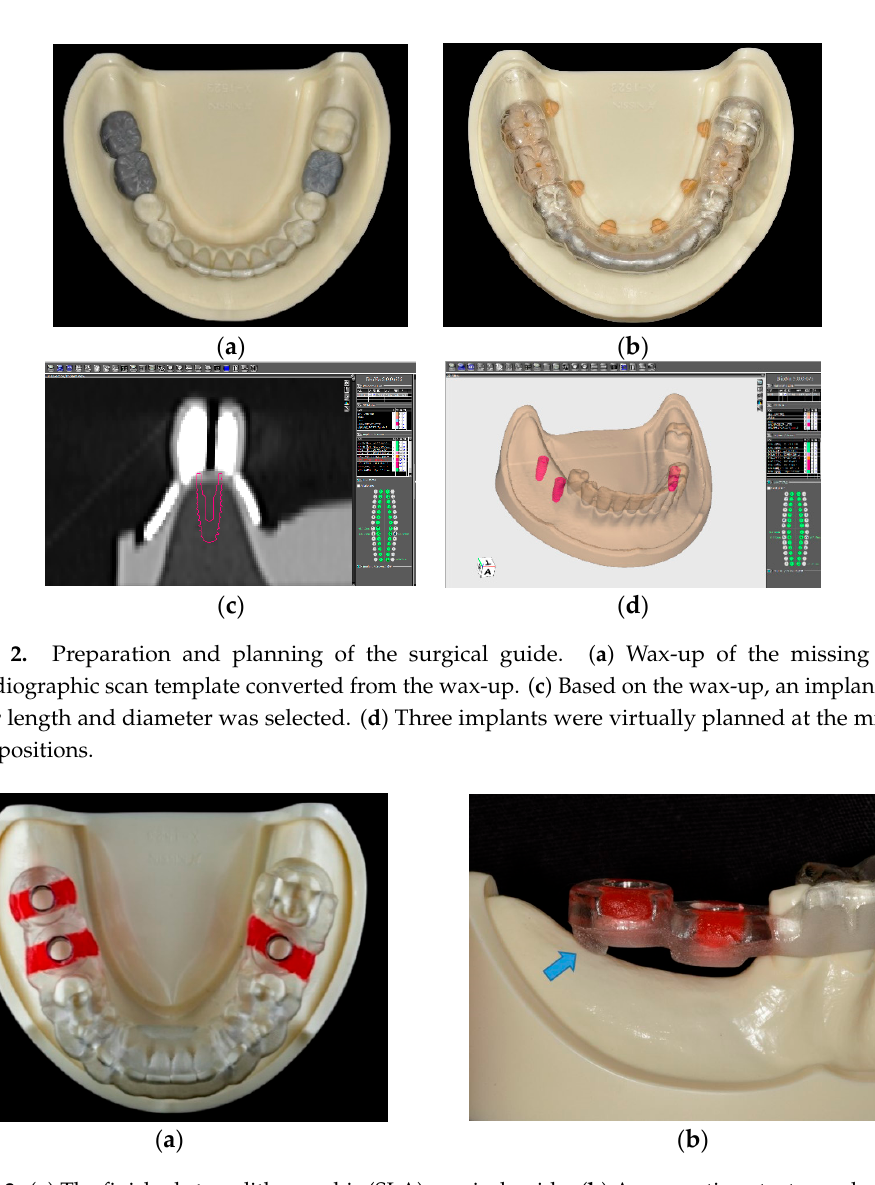
Figure 3. ( a ) The finished stereolithographic (SLA) surgical guide. ( b ) A supporting strut was designed in the distal part of the surgical guide to offer a combination tooth-and-bone support (blue arrow).